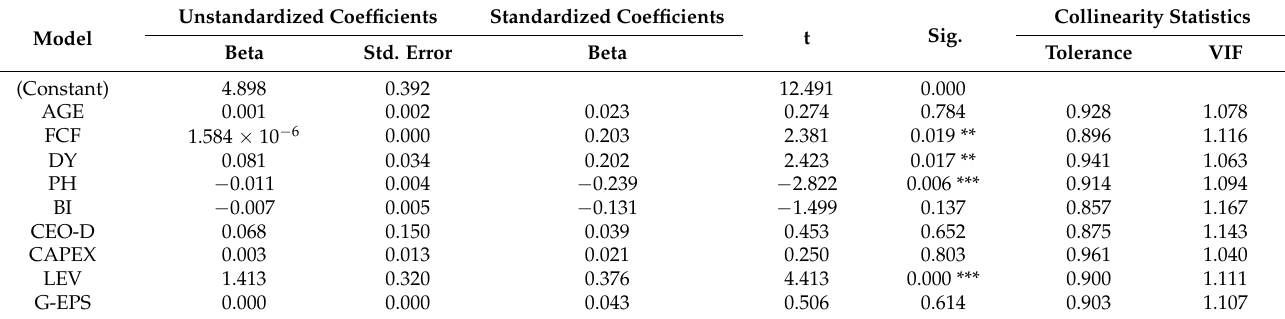
Table 4. Regression Results for Equation